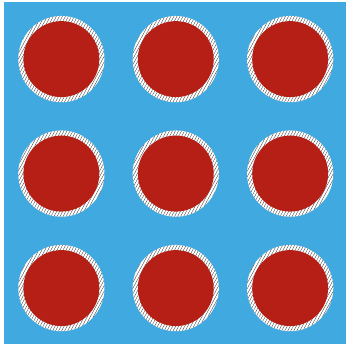
Figure 4: Top view schematic drawing of the 9-rod